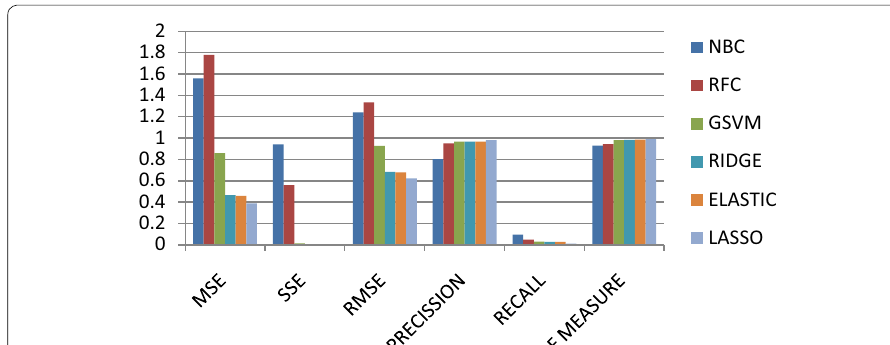
Fig. 3 Performance metrics for different classifiers under ORL database